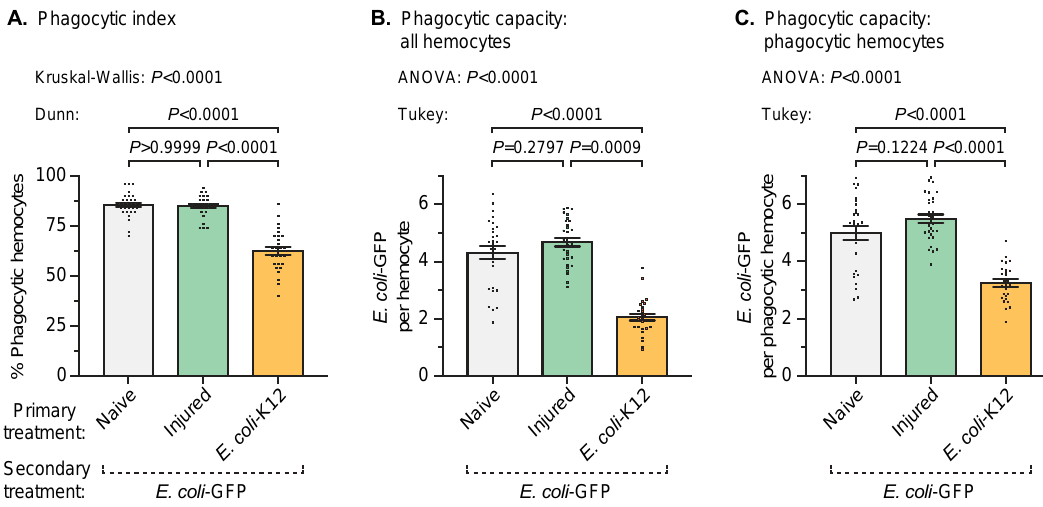
Figure 4. Phagocytic index and phagocytic capacity after secondary treatment. Five days after the primary treatment of naïve, injury, or infection with E. coli -K12, all the mosquitoes were infected with E. coli -GFP and 1 hr later the following phenotypes were measured: the percentage of hemocytes that phagocytosed E. coli -GFP ( A ), the average number of E. coli -GFP phagocytosed by each hemocyte ( B ), and the average number of E. coli -GFP phagocytosed by each phagocytic hemocyte ( C ). Column heights mark the mean and whiskers denote the SEM. Circles mark the phagocytic activity in individual mosquitoes.